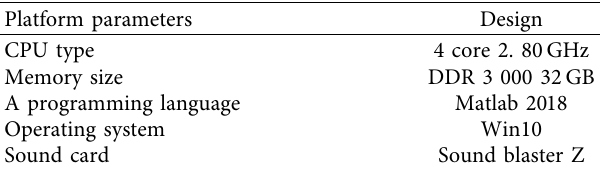
Table 2: Test platform of music classification simulation experiment.